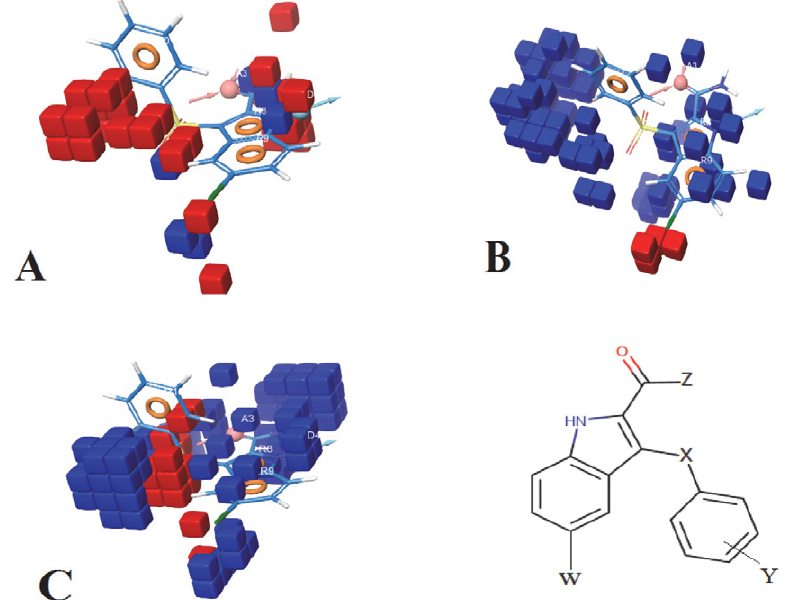
Fig. 5. QSAR model visualized in the context of favorable and unfavorable effects in compound: (A) hydrogen bond donor, (B) hydrophobic/ non-polar and (C) negative ionizable